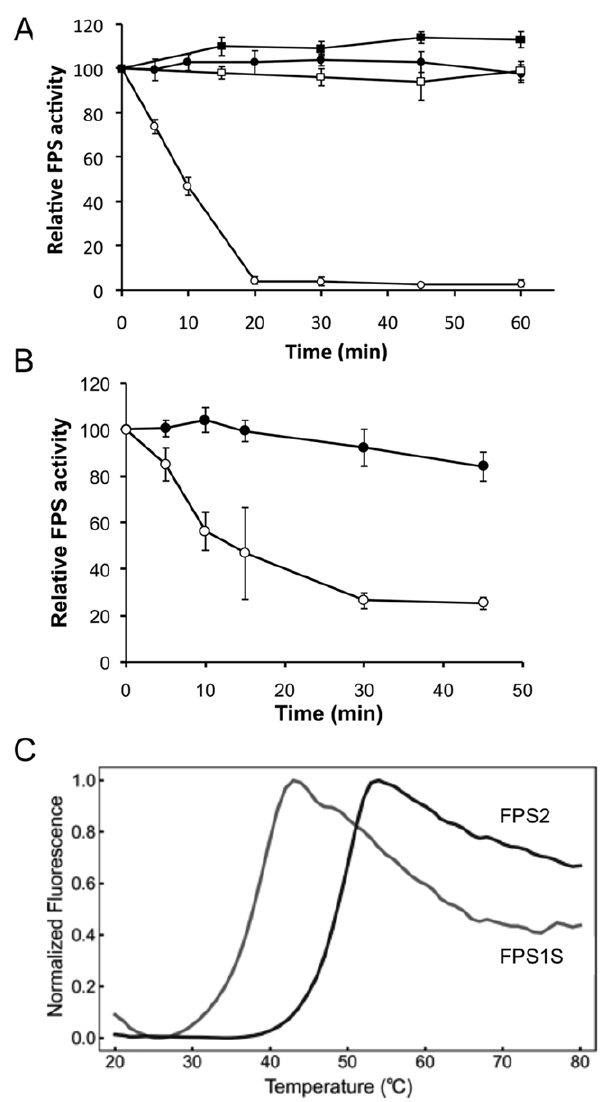
Figure 3. Thermal stability of FPS1S and FPS2 enzyme activity. (A) Activity of purified FPS1S (open symbols) and FPS2 (closed symbols) was measured after incubation at either 37 u C (squares) or 45 u C (circles) for the indicated time periods. (B) FPS activity in 16,000 g protein extracts from fps1-1 (FPS2 activity, closed circles) and fps2-1 (FPS1 activity, open circles) mutants was determined after incubation at 45 u C for the indicated times. In both cases enzyme activities are expressed relative to the FPS activity values at time 0 min and the mean values and SE were calculated from three independent experiments. (C) Differential scanning fluorimetry (DSF) results plotted as change in fluorescence emission intensity (normalized to unity at its maximum) with increasing temperature (20–80 u C). The FPS1S and FPS2 curves correspond to 6 m M enzyme.